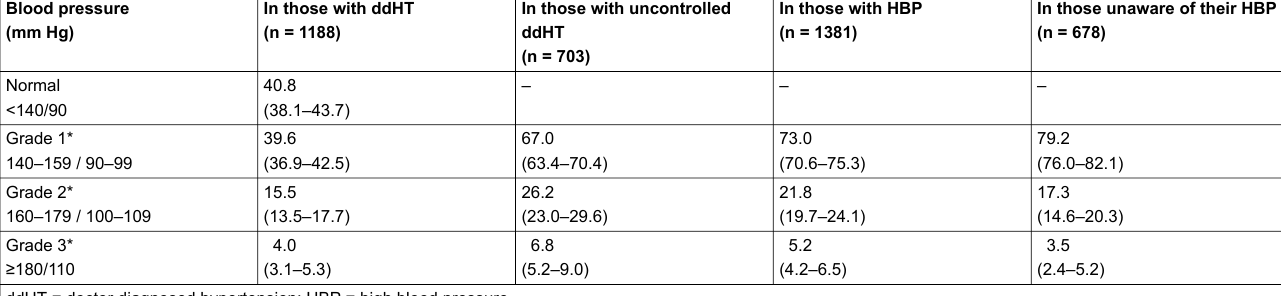
Table 2: Distribution of blood pressure measurements, by hypertension- or high blood pressure-group (data are proportion of group with 95% confidence interval). Blood pressure (mm